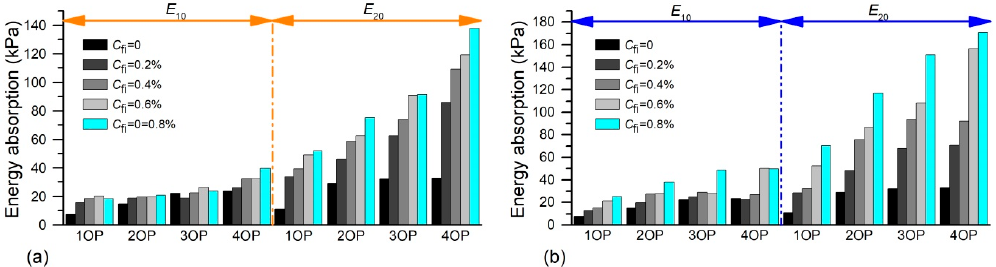
Figure 9. The variation of E 10 and E 20 of treated sand with polymer and fiber contents: ( a ) OPSS and OPCFRS. ( b ) OPSS and OPSFRS.